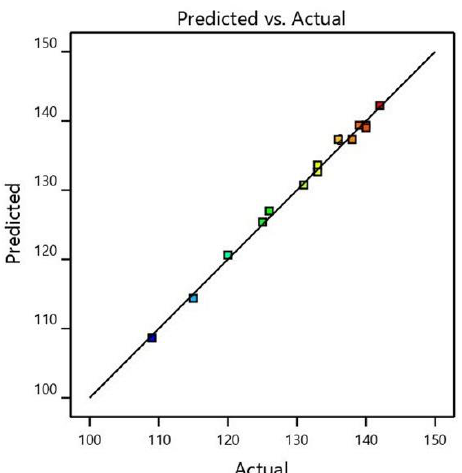
Figure 2. Design-expert plot; predicted vs. actual values plot for steady-state permeability.